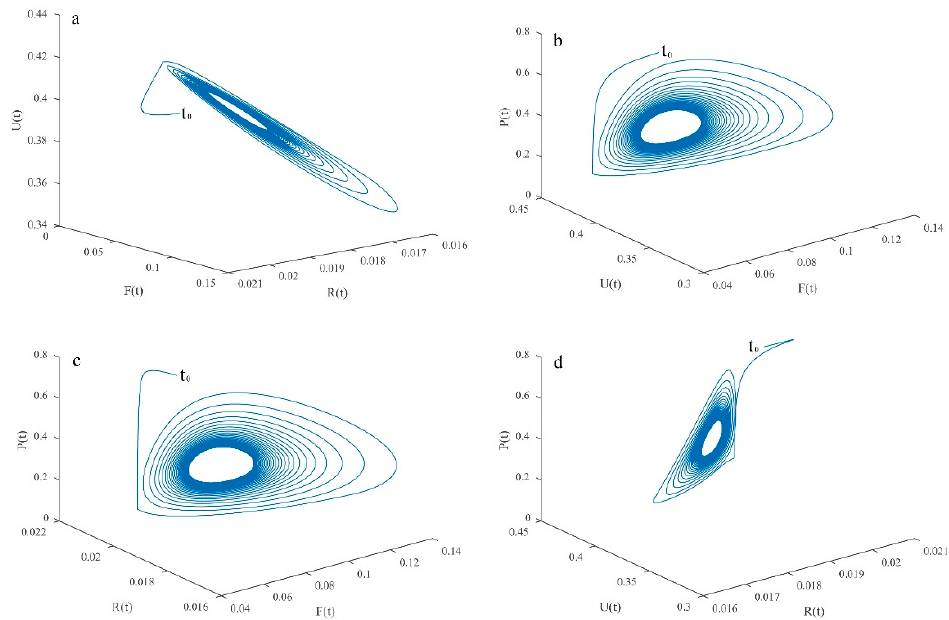
Figure 6. Three-dimensional map of human–land evolution in Yuxi City when τ = 740 (( a ) three-dimensional evolution of the unused land, forest and grass land and production and living land over time; ( b ) three-dimensional evolution of the population, unused land, and forest and grass land over time; ( c ) three-dimensional evolution of the population, production and living land and forest and grass land over time; ( d ) three-dimensional evolution of the population, unused land and production and living land over time).